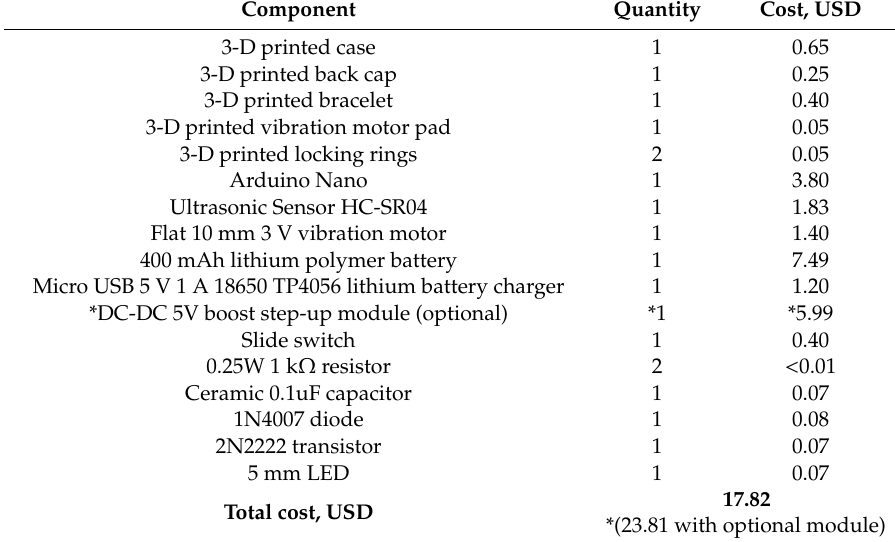
Table 1. Bill of materials for the open-source ultrasound-based navigational support.